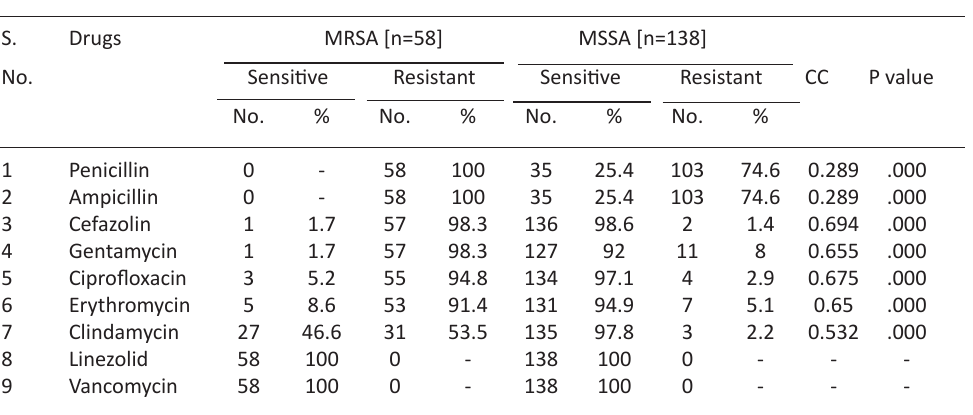
Table 5. Comparison of Resistance pattern of MRSA isolates by various studies S.